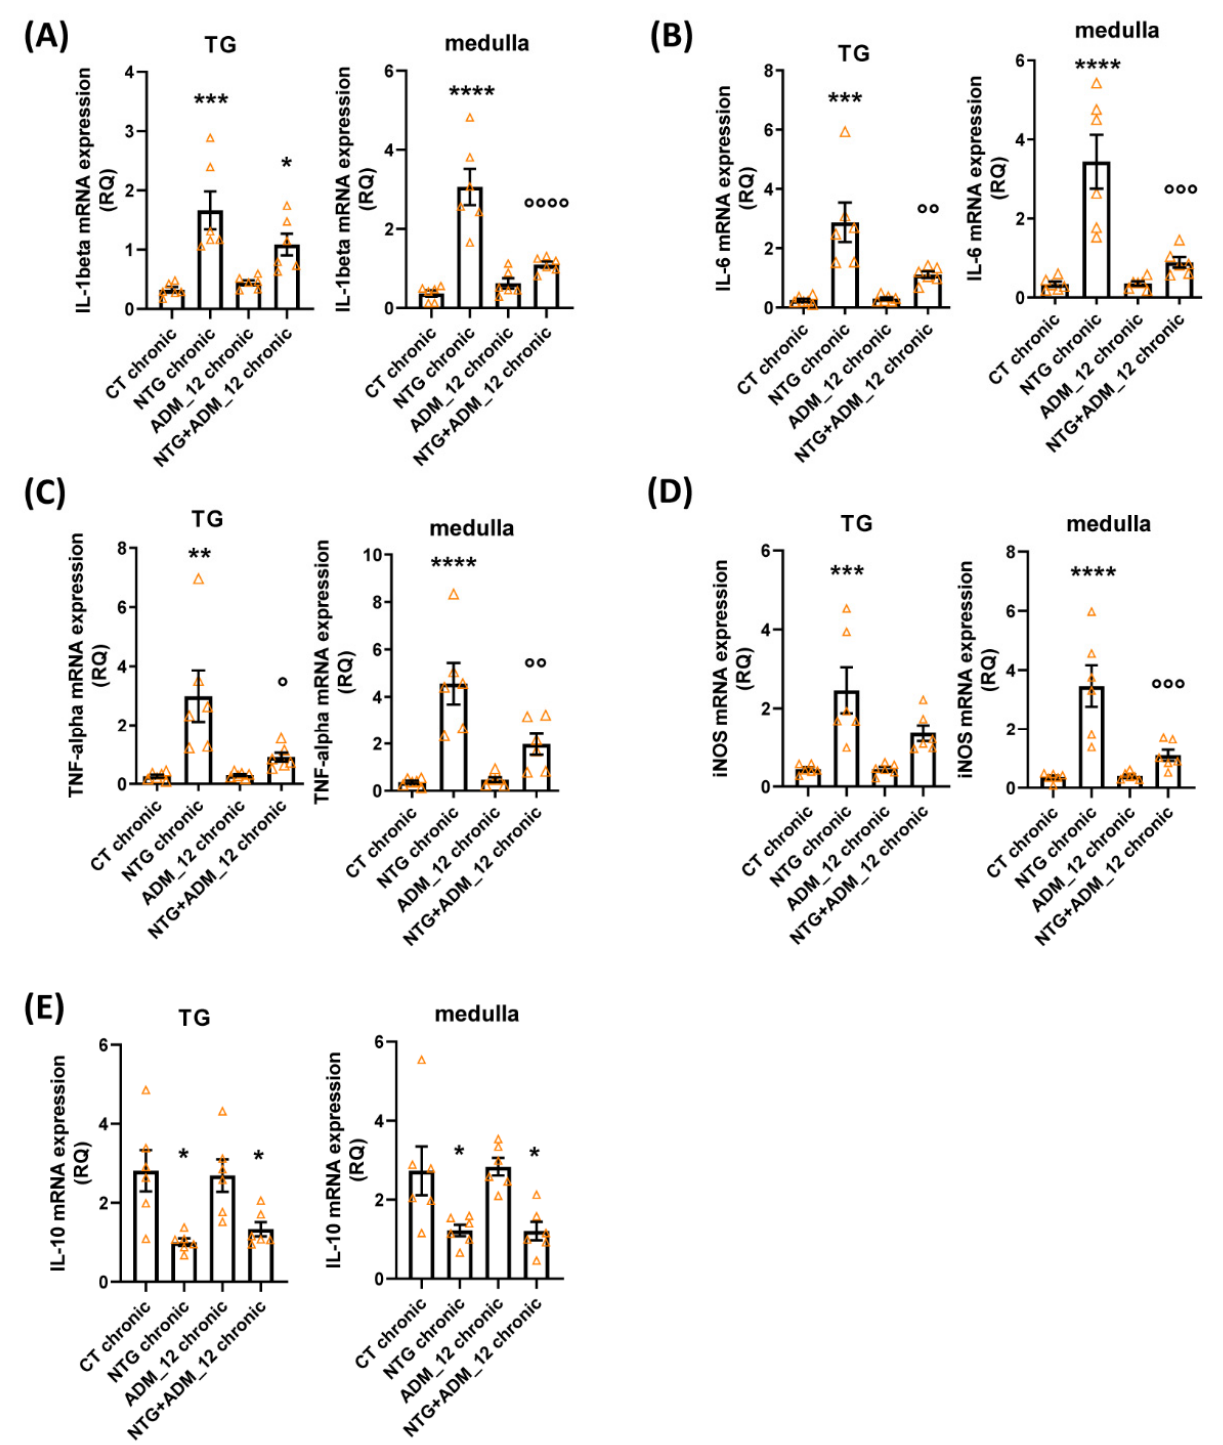
Figure 7. Effects of ADM_12 (30 mg/kg) on the gene expression of pro- and anti-inflammatory mediators in the Medulla oblongata and following the TG ipsilateral to formalin injection. ( A ) IL-1beta, ( B ) IL-6, ( C ) TNF-alpha, ( D ) iNOS, ( E ) IL-10 mRNA levels (expressed as relative quantification, RQ; see Section 4 for details) in the chronic migraine model ( n = 6 per group). CT: Control. * p < 0.05, ** p < 0.01, *** p < 0.001 and **** p < 0.0001 vs. CT chronic and ADM_12 chronic; ° p < 0.05, °° p < 0.01, °°° p < 0.001 and °°°° p < 0.0001 vs. NTG chronic. Data are expressed as the mean ± SEM; one way ANOVA followed by Tukey’s multiple comparisons test.